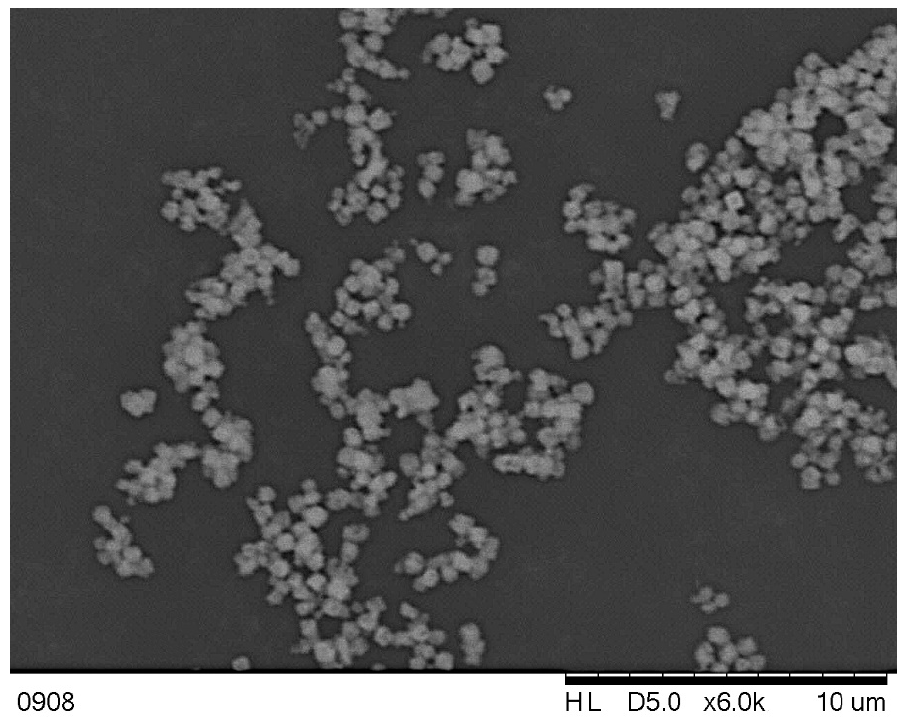
Figure 2. SEM images of CaF 2 particles precipitated in STR—silent conditions. Operating conditions: ε mix = 0.4 W/kg, Re eqv = 3022, τ = 6 s, V = 150 L/h (Hitachi TM 3000, magnification 6000×, size bare: 10 µ m).